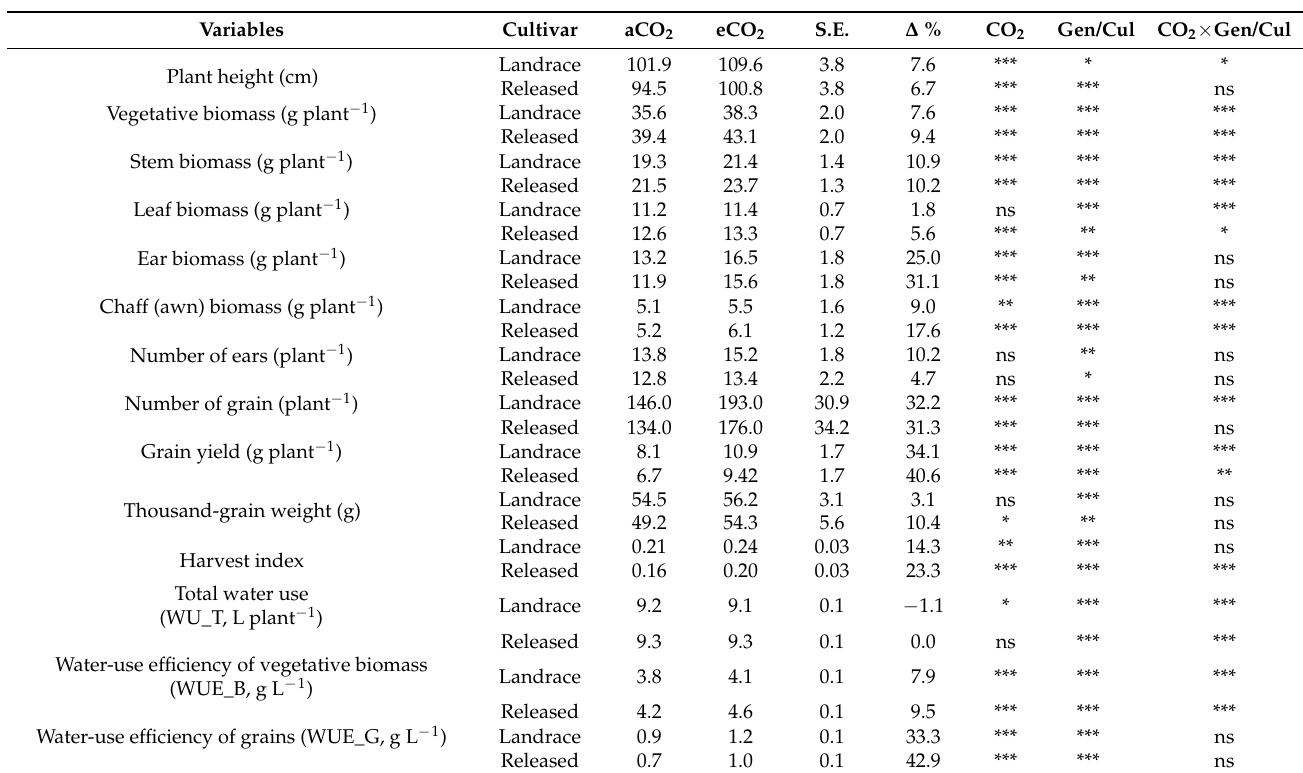
Table 1. Analysis of variance results. Mean and standard error (S.E.) of phenological parameters of landrace (Gen) and released cultivars (Cul) under ambient and elevated CO 2 conditions, as well as their interactions. Variables Cultivar Plant height